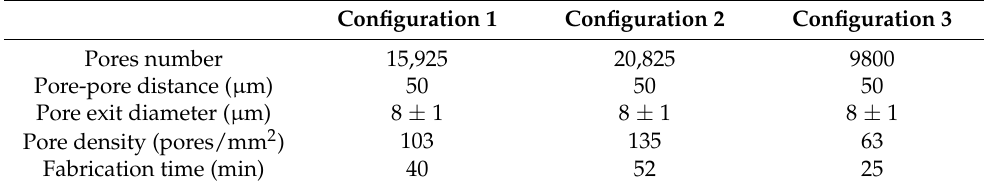
Figure 5. Pictures of the three layouts (Configuration 1, 2 and 3 respectively in section ( a – c ) of the figure) reproduced by fs-laser drilling on the CKC bottom surface. Pore dimensions: 8 ± 1 µ m. Distance between pores: 50 µ m. Table 2. Characteristics of CKC membrane configurations. The values are referred to the bottom surface of the membranes. Configurations 1, 2 and 3 are referred to as the description in Figure